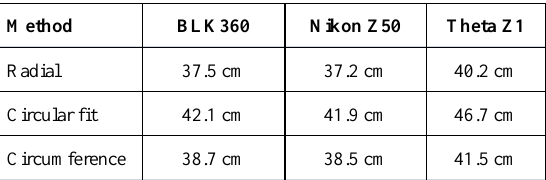
Table 1. Comparison of DBH from three 3D methods using different computation